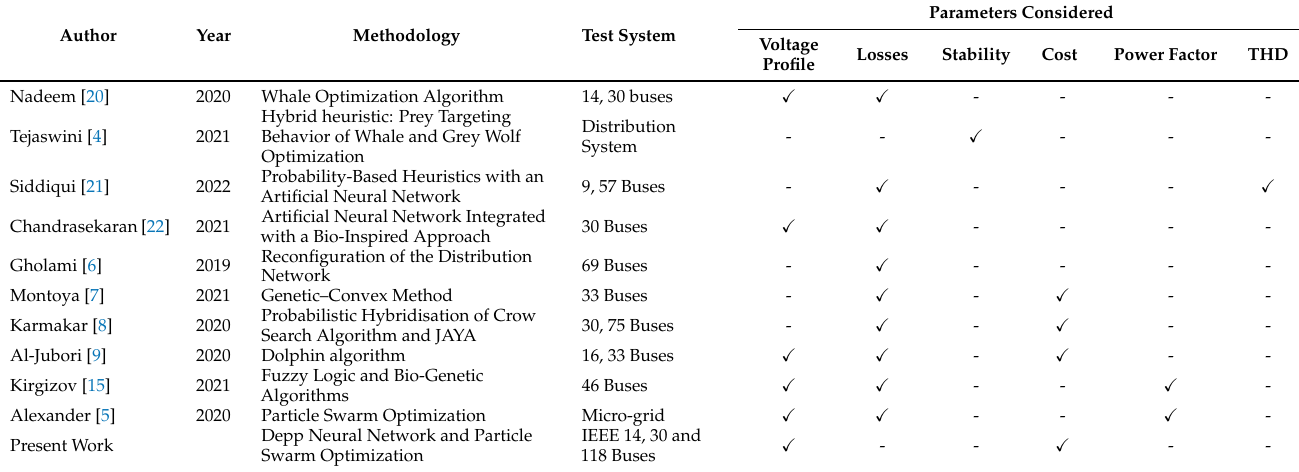
Table 1. Most relevant results and methodologies for reactive compensation in the literature